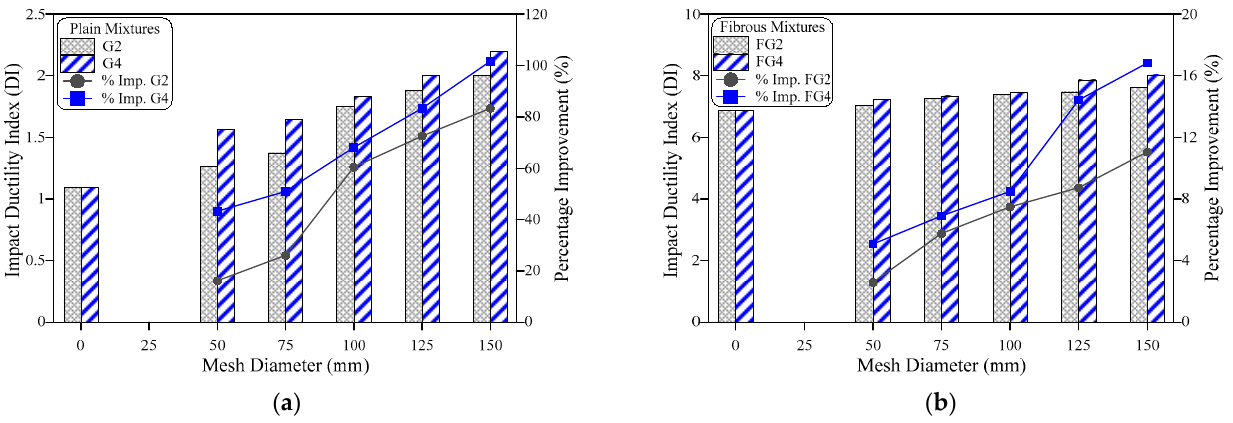
Figure 13. Effect of mesh diameter (ratio of reinforcement surface) on the impact ductility of ( a ) plain mixtures, ( b ) fibrous mixtures.